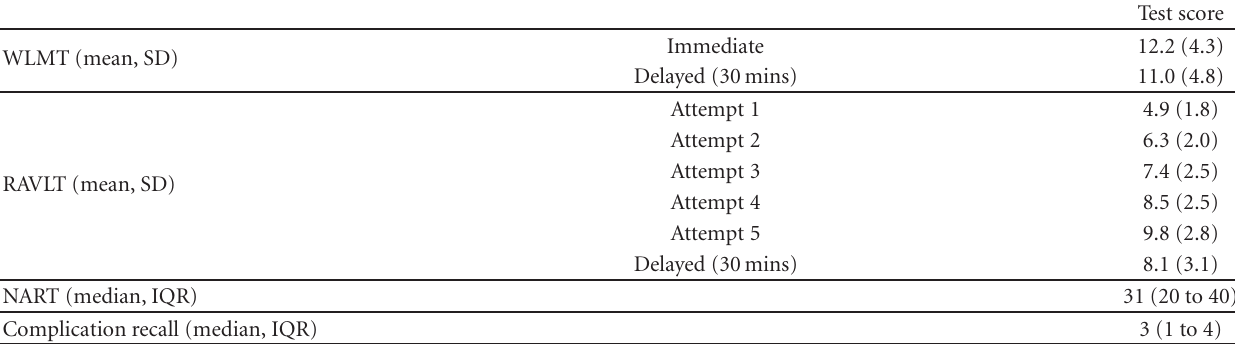
Table 2: Results of Weshchler Logical Memory Test (WLMT), Rey Audio-Verbal Learning Test (RAVLT), National Adult Reading Test (NART), and recall of complication list at time of admission.